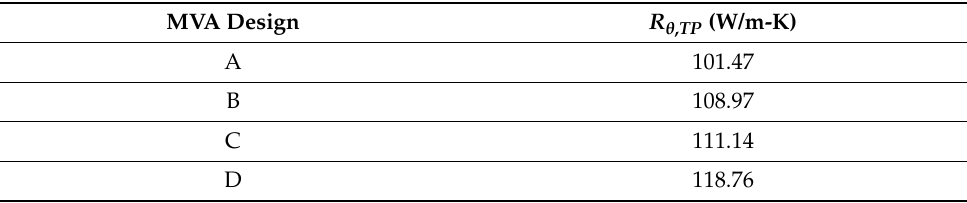
Figure 2. A generalized schematic representing the 1D though-plane thermal resistance of an MVA. Table 3. Through-plane thermal conductivity for each MVA design.